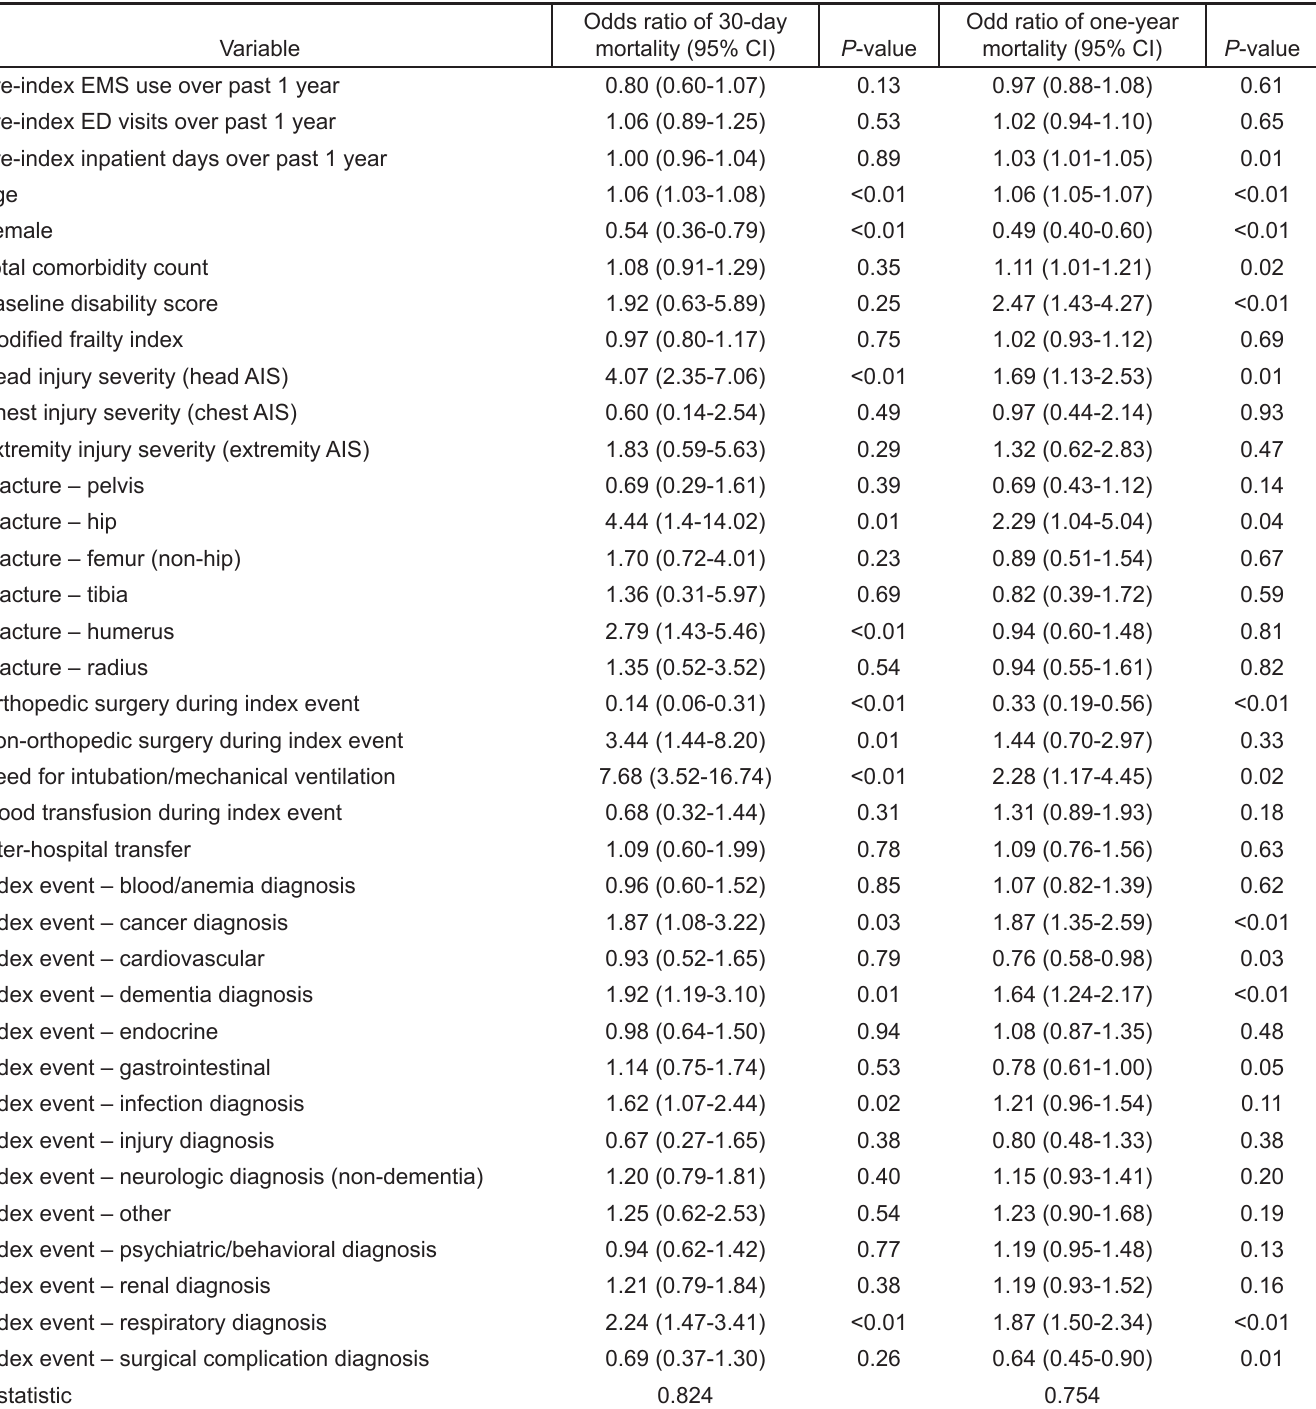
Table 3. Multivariable model for 30-day and one-year mortality among community-dwelling older adults transported by ambulance after a fall (N =